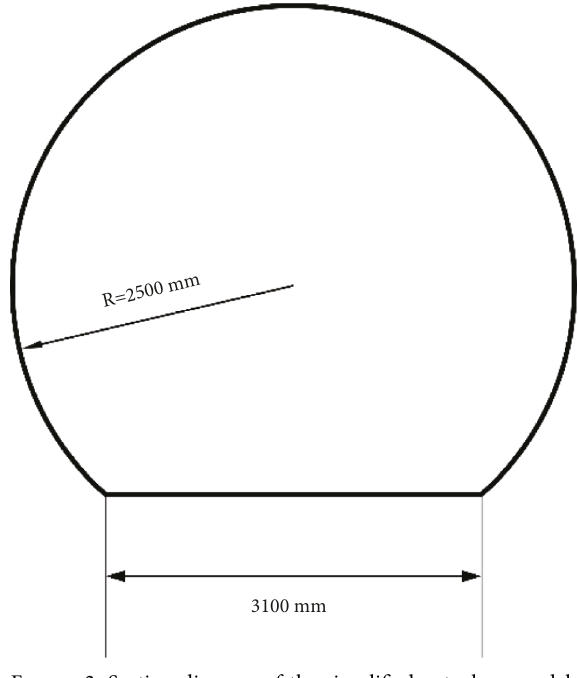
Figure 2: Section diagram of the simplified autoclave model.